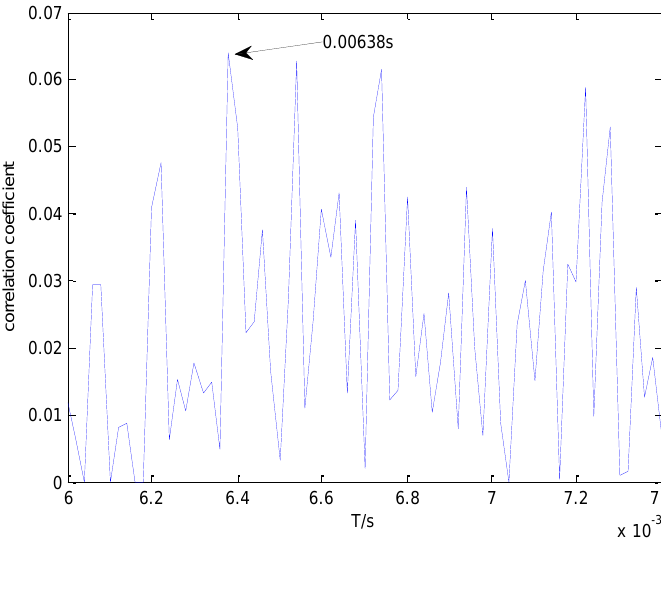
Figure 21. Maximal correlation coefficients for different elements from set T, using the conventional method on the inner race fault